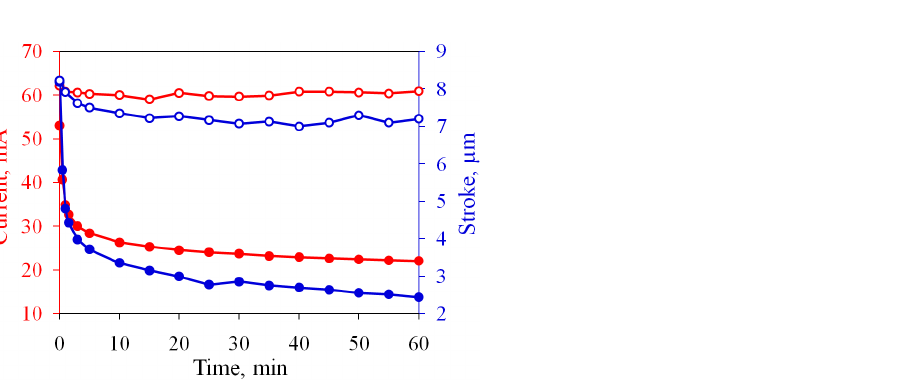
Figure 3. Time dependence of the average current and stroke. Filled and open circles correspond to the normal and new regimes, respectively.